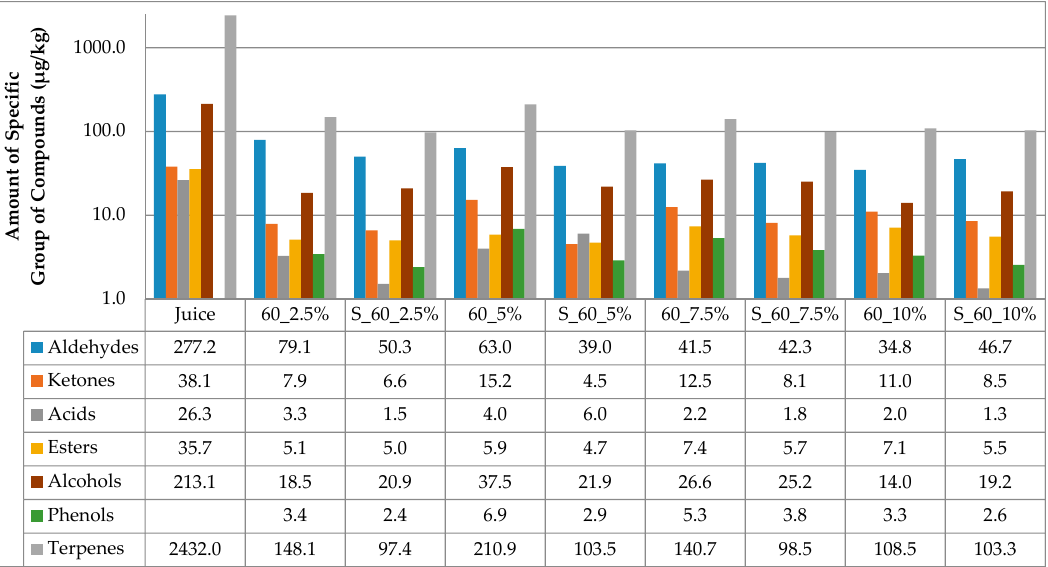
Figure 2. Amount of volatiles of specific chemical group in juice and on cellulose/raspberry complexes after 60 min of complexation and after storage (2.5%, 5%, 7.5% and 10%—amounts of used cellulose; 60—time of complexation; S—storage.